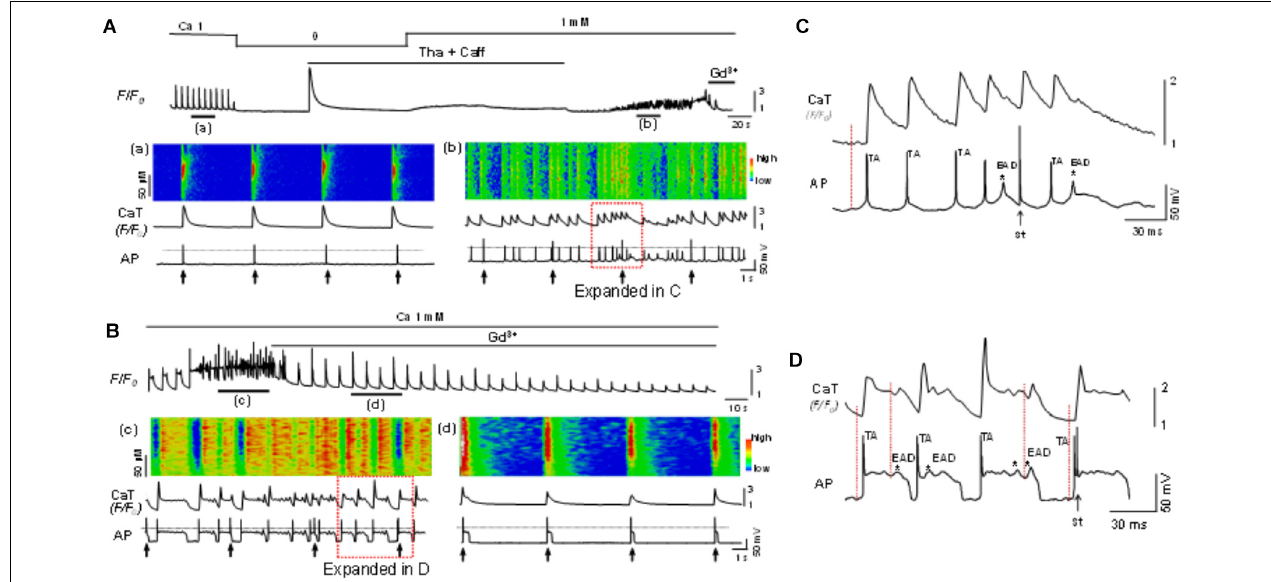
FIGURE 6 | Store-operated calcium entry contributes to cellular arrhythmogenesis. (A) Top panel: A Ca 2 + fluorescence ( F/F 0 ) recording. (a,b) : Simultaneous recordings of linescan image, whole-cell calcium fluorescence ( F/F 0 ) and action potentials (AP) at the time windows a and b indicated in the top panel. The cell was paced at a pacing cycle length (PCL) of 6 s (indicated by the arrows underneath the AP trace). EADs, DADs and triggered APs appeared after SOCE was activated, indicating SOCE contributes to the generation of arrhythmias. (B) In another cell, the same protocol as in A was used to activate SOCE. The SOCE-induced EADs (indicated by the asterisks), DADs, and triggered APs (c) were eliminated by Gd 3 + (1 mM) (d) . The 0 mV level is indicated by the dotted line in each panel. (C) Expanded region within the red box as indicated in (Ab) . (D) Expanded region within the red box as indicated in (Bc) . Note initiation (indicated by the dotted vertical lines) of the spontaneous depolarization phase (DADs triggering action potential) and occurrence of EADs (indicated by ∗ ) preceded the elevation of intracellular Ca 2 + . TA, triggered action potential; St, stimulation.